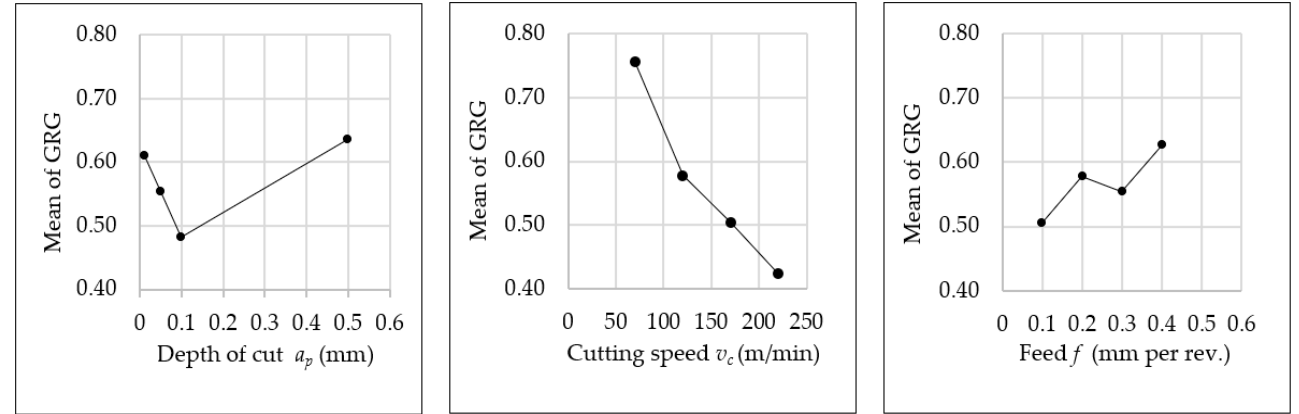
Figure 12. Main effect plot of mean grey relational grade.